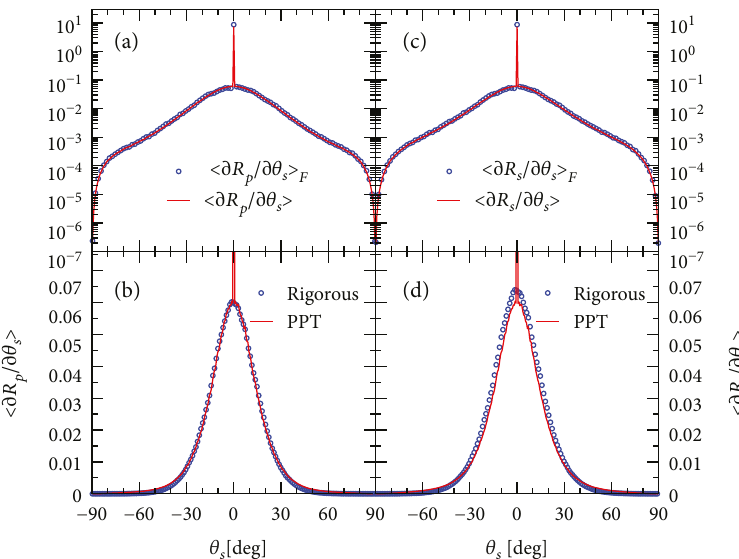
/ ∂ θ / ∂ θ Figure 4: The quantities ∂ R and ∂ R obtained for a vacuum-glass system [ ε 1 = 1 and ε 2 = 2 25 ] plotted on semilogarithmic v s F v s scales for ν = p [Figure 4(a)] and ν = s [Figure 4(c)]. Comparison of the mean di ff erential re fl ection coe ffi cients ∂ R either a rigorous simulation approach or on the basis of phase perturbation theory (PPT) for p-polarized (Figure 4(b)) or s-polarized (Figure 4(d)) illumination. All ensemble averaged quantities were obtained on the basis of N function. The remaining parameters are identical to those of Figure 2.